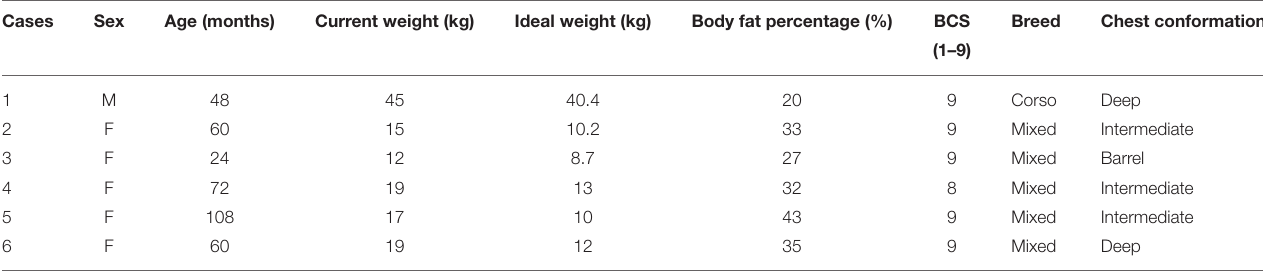
TABLE 1 | Patient characteristics in a group of six anesthetized obese dogs with varying degrees of body fat percentage undergoing computed tomography scans, and ventilated with tidal volumes based on current vs. ideal body weight. Cases